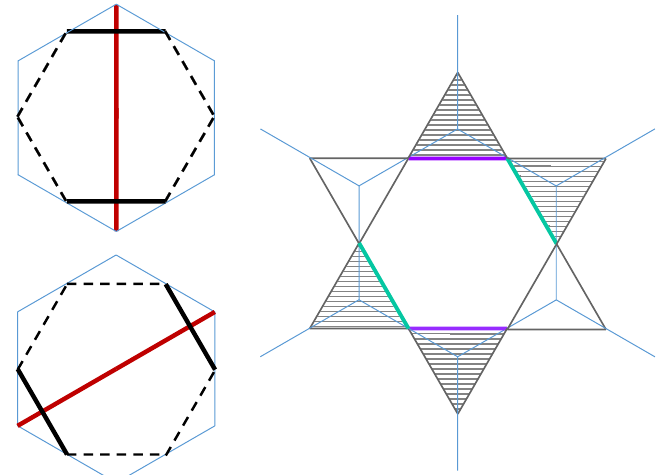
Figure 10: Hexagonal building block before (top left) and after (bottom left) a π/ 3 rotation. Induced changes to the bond distribution (right). Violet and green lines represent antiferromagnetic bonds that were replaced by ferromagnetic bonds, and vice versa. The elementary loops surrounding the rotated building block that changed their parity due to the rotation are indicated by dashed background. the defect